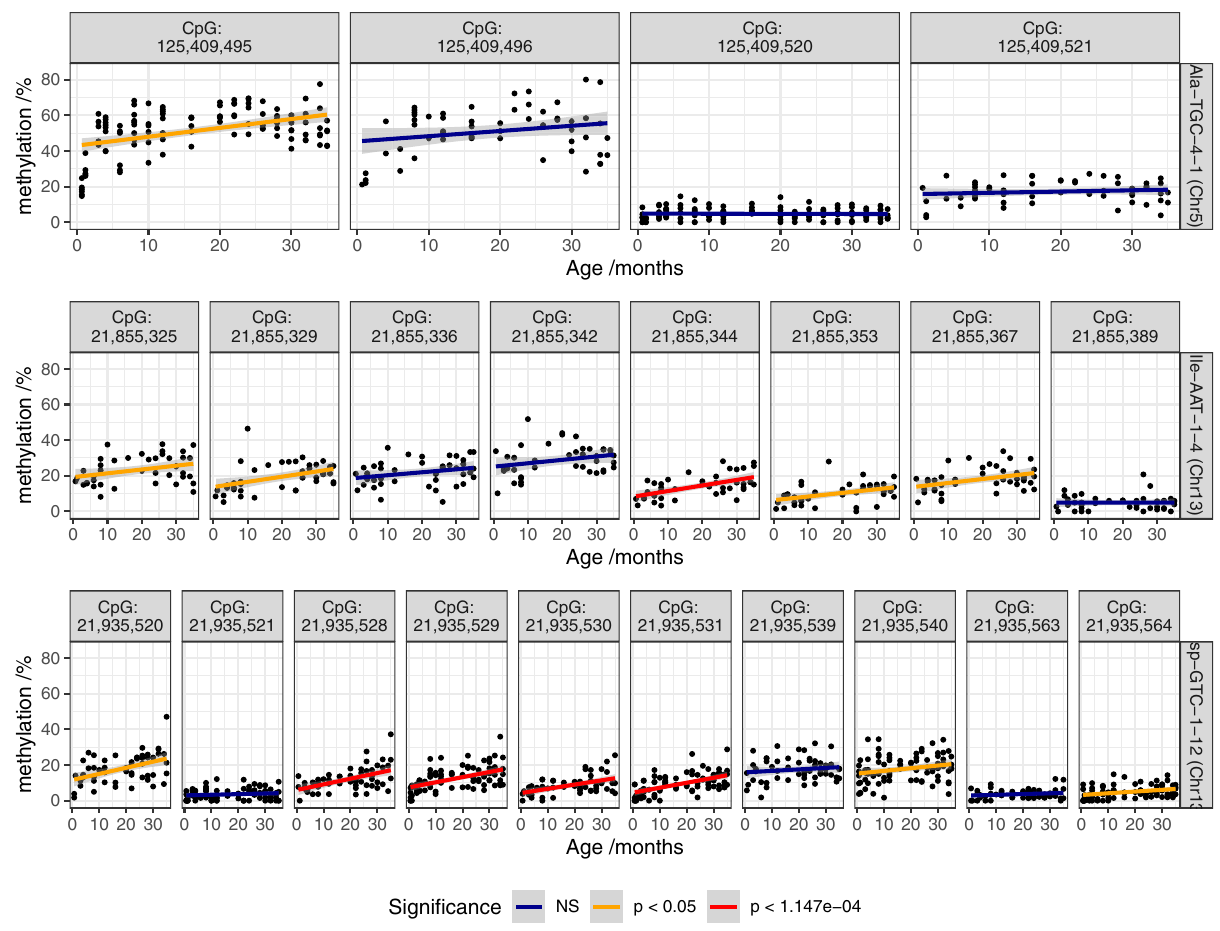
Fig. 8 DNA methylation of CpGs in 3 tRNA genes which signi fi cantly hypermethylate with age in mice. Data from Petkovich et al. 61 . Six CpGs reach Bonferroni signi fi cance and seven show nominally signi fi cant increases. Source data are provided as a Source Data fi